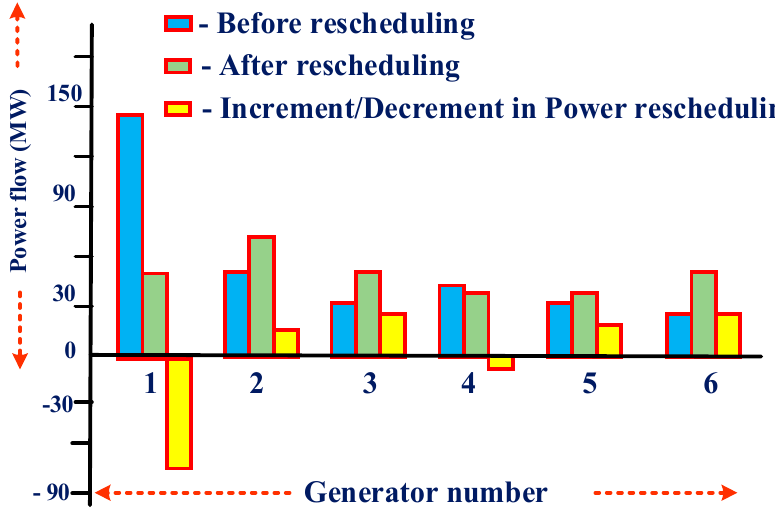
Figure 8. Mitigation of congestion employing Flower Pollination Algorithm.